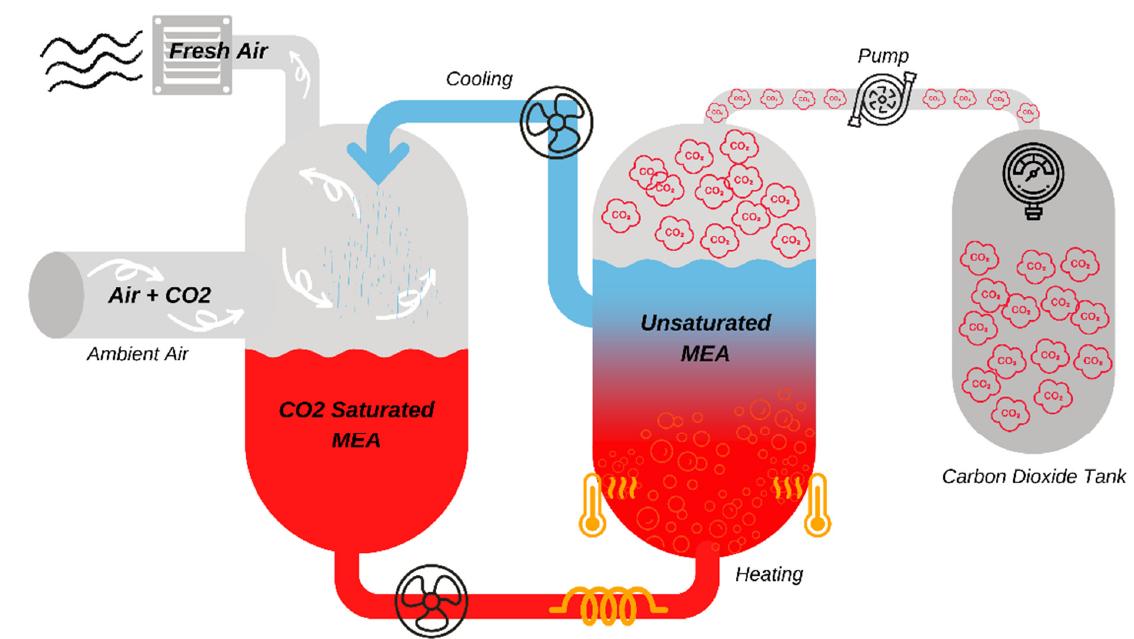
Figure 1. Process steps for isolation of CO 2 in ambient air.